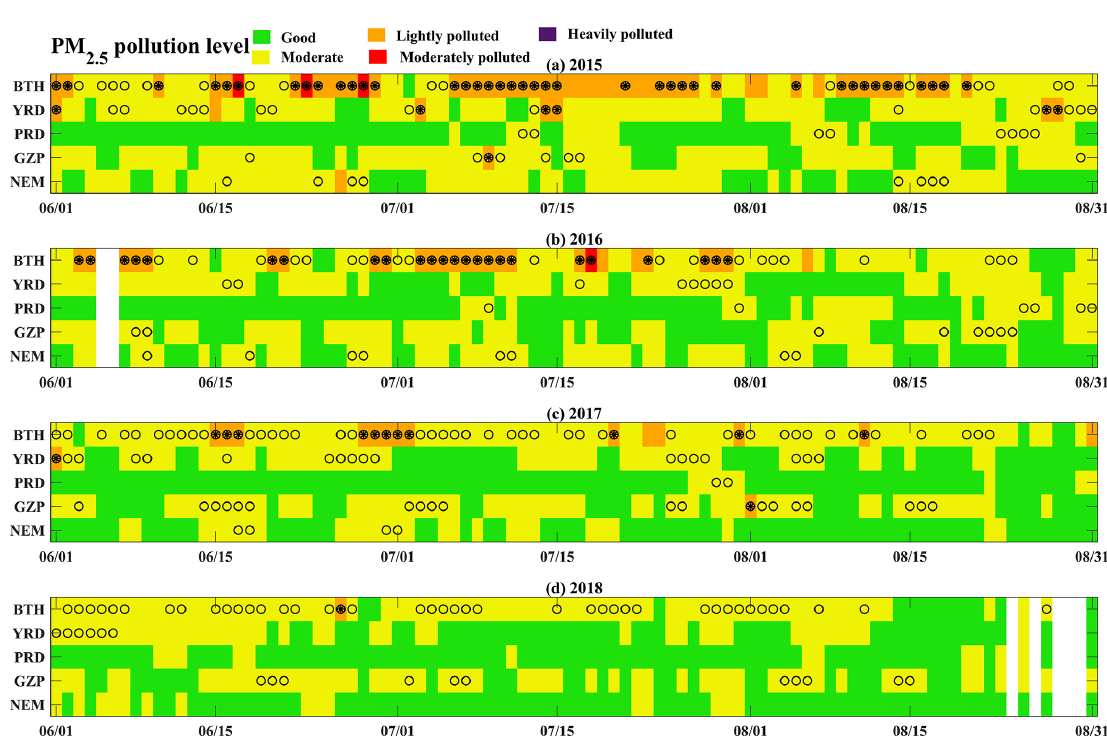
Figure 3. Time series of PM 2 . 5 pollution levels in key urban clusters. Black dots indicate the compound events. Asterisks indicate the compound events under the Chinese standard (WHO interim target 1; IT-1) and the circles indicate the compound events under WHO IT-2.